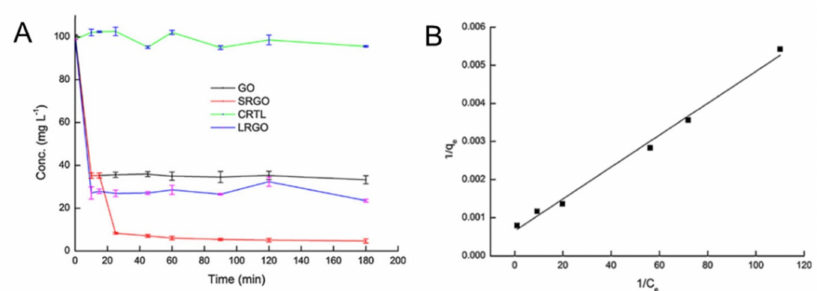
Figure 9. ( A ) Time-dependent adsorption of dye acridine orange by GO, in-situ reduced GO(SRGO), three-hour-long pre-reduced GO (LRGO) versus the blank group, AO ~100 mg/L, 50 mL; ( B ) Adsorption isotherms fitted by the Langmuir model: the reciprocal of equilibrium concentration versus that of equilibrium capacity. Adapted with permission from [99]. Copyright Elsevier,